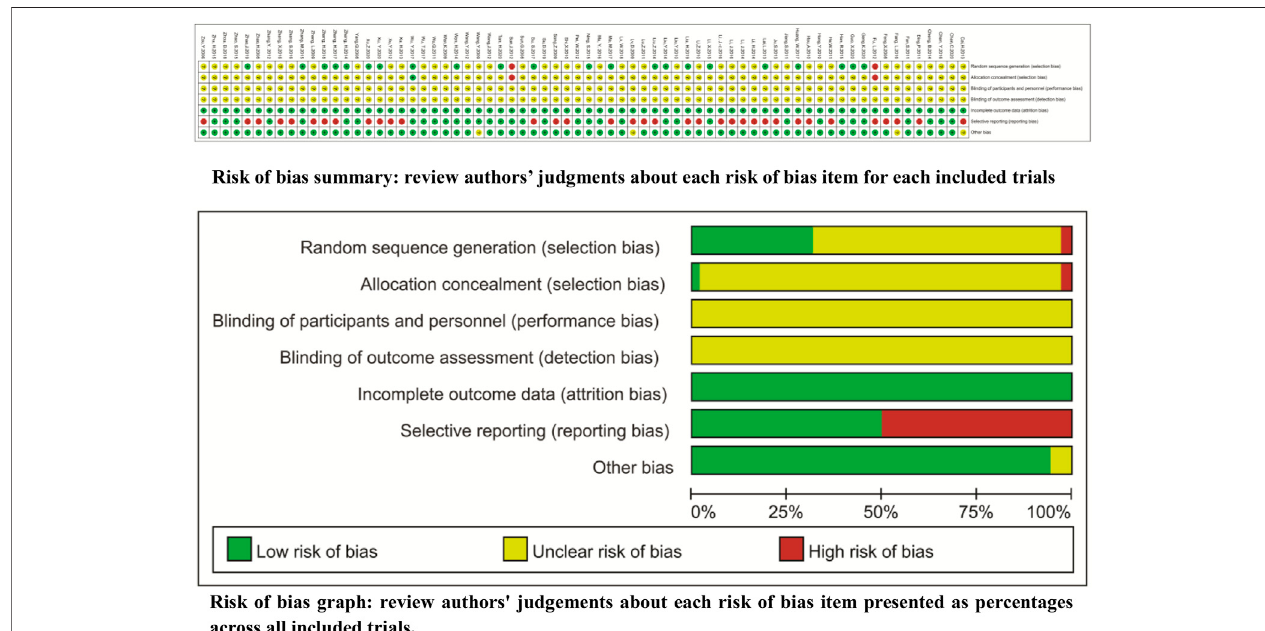
FIGURE 2 | Risk of methodological bias Only 24 trials reported the random number table, draw, computer random, or odd – even random. Two trials reported the exposure of allocation. None of the trials reported the blinding and all trials had complete follow-up.